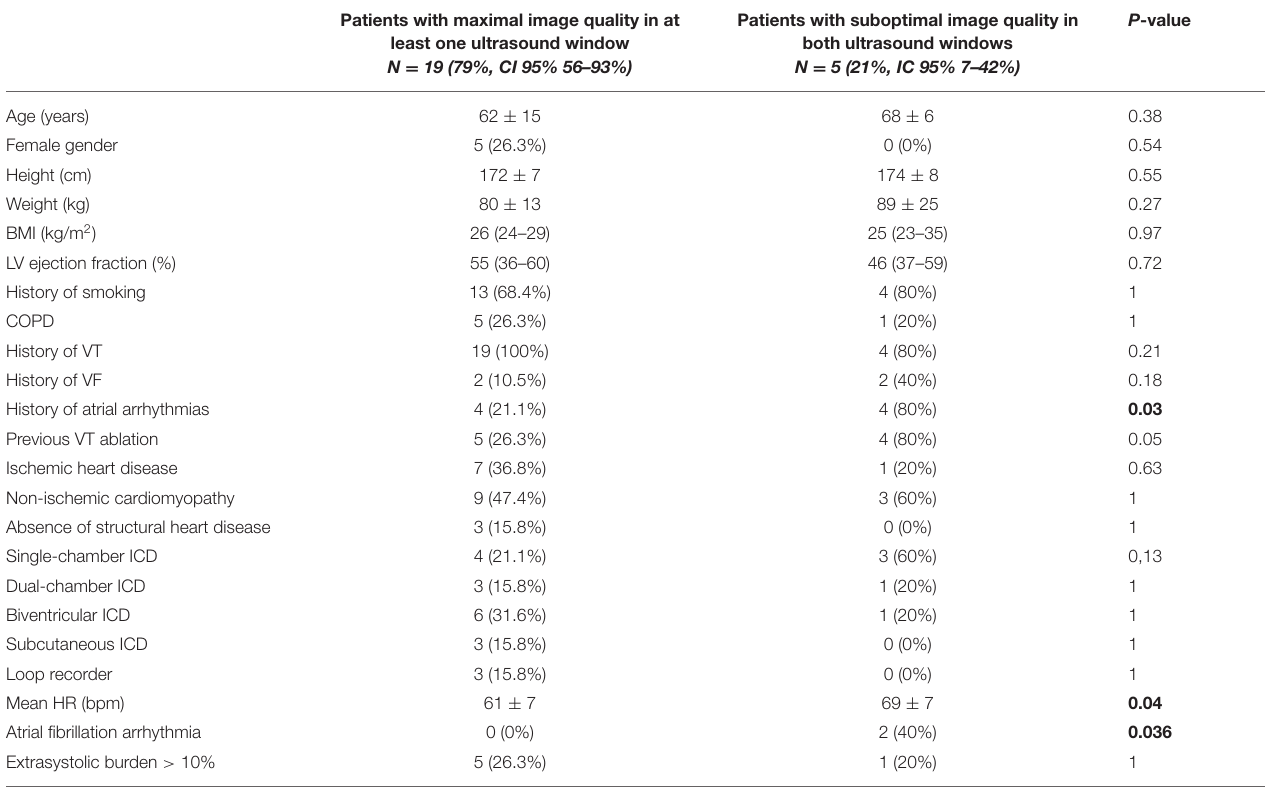
TABLE 4 | Comparison of the clinical demographic characteristics of patients with maximal image quality versus those with lower image quality. Patients with maximal image quality in at least one ultrasound window